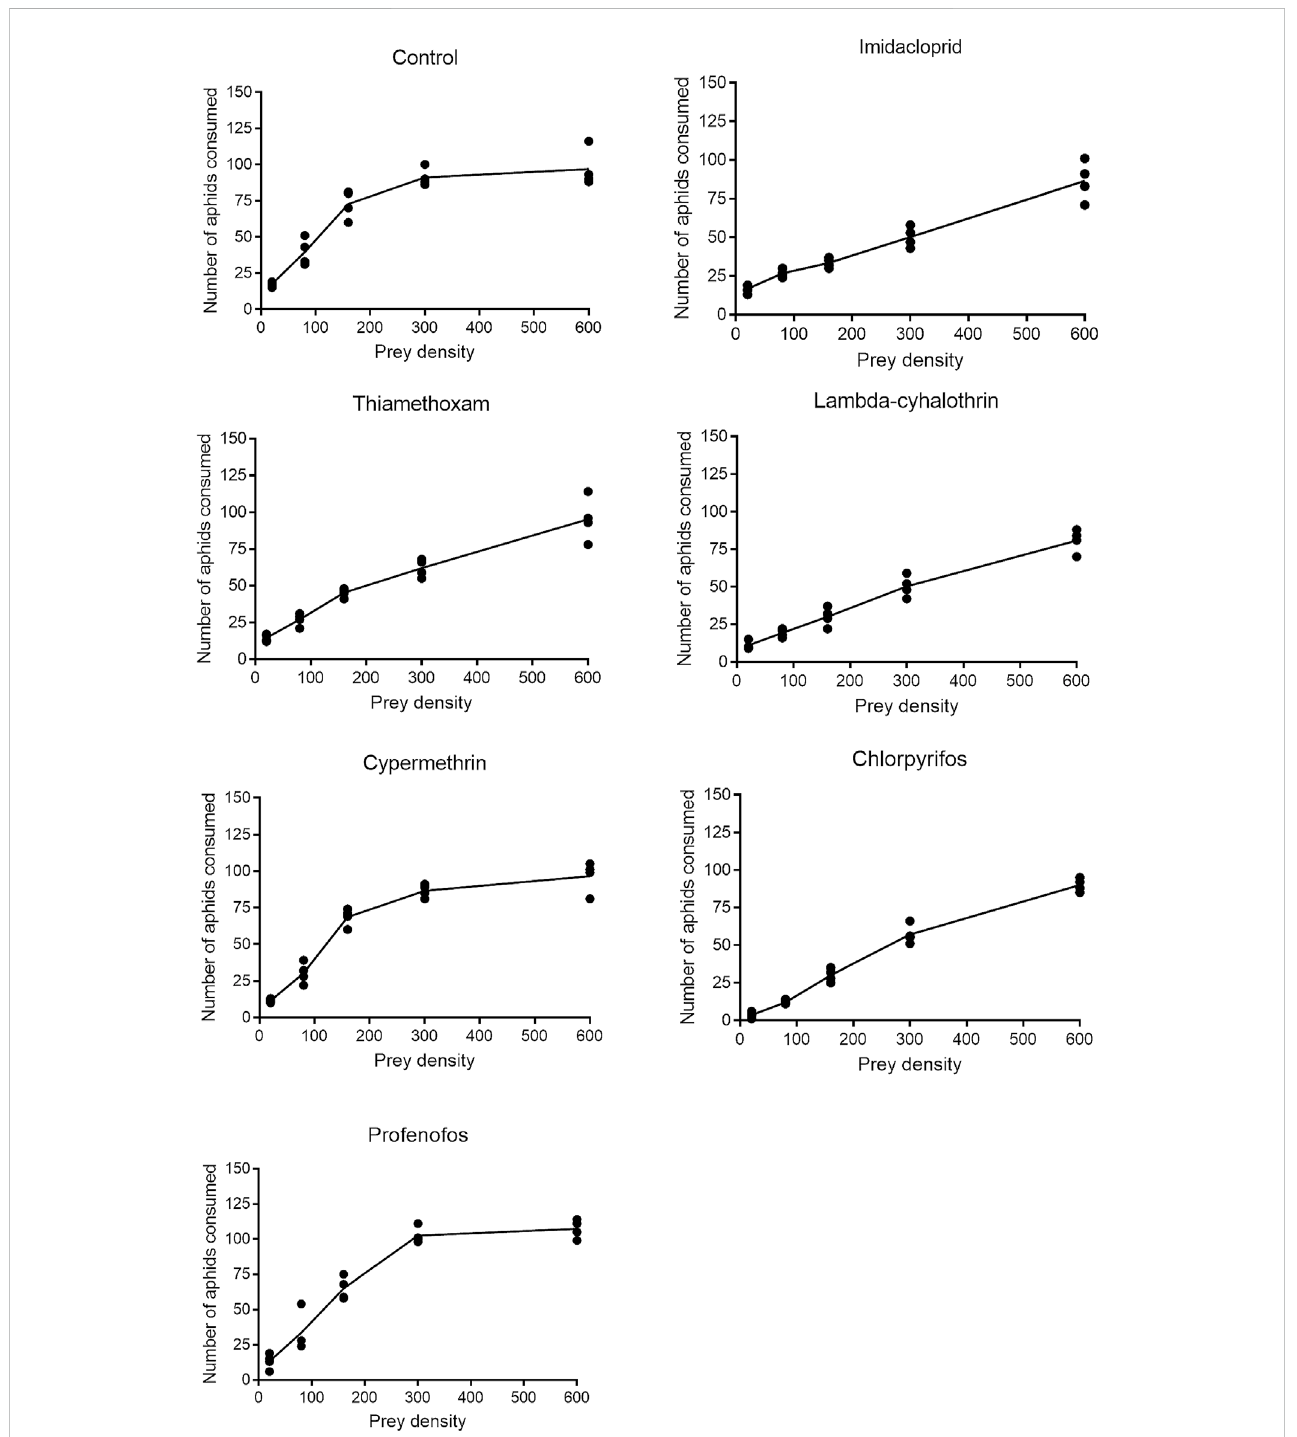
Population parameters such as intrinsic ( r ) and fi nite ( λ ) rates of increase, net reproductive rate ( R 0 ) and mean generation time ( T ) can be useful to better understand the population dynamics of insects (Liu et al., 2017; Zheng et al., 2017; Negi et al., 2018; Jiang et al., 2019). Results showed that the treatment of F 0 with sublethal doses of